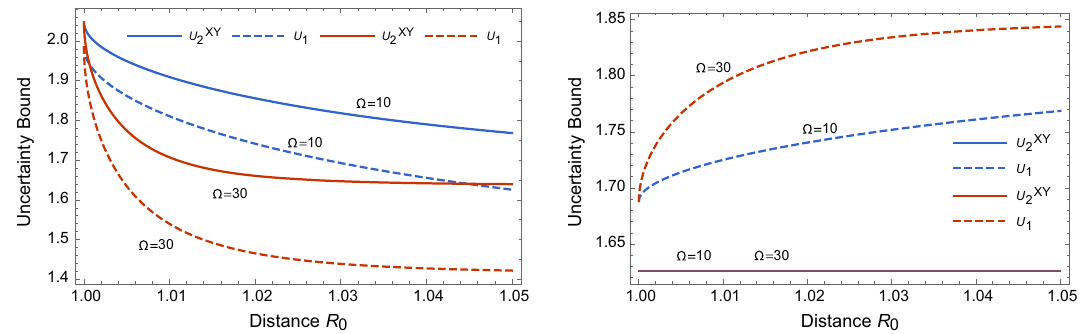
Fig. 5 Given Ω = ω/ T H = 10 or 30, U xy